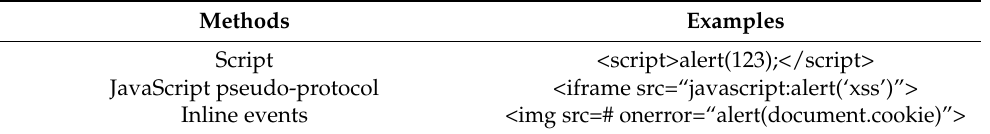
Table 4. XSS attack